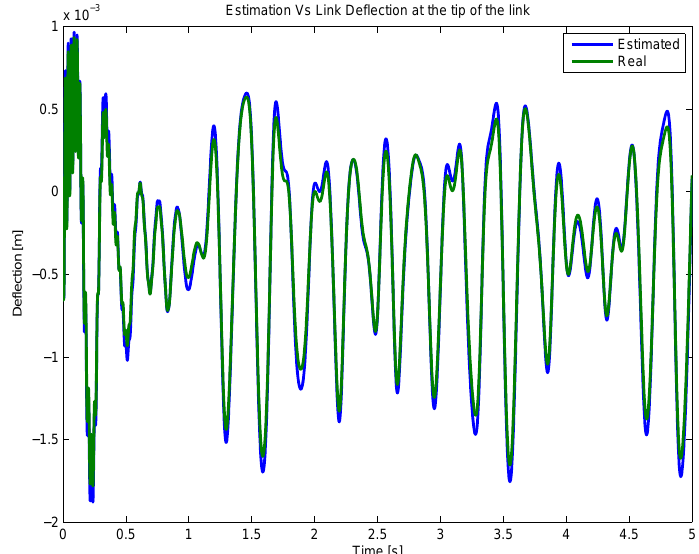
Figure 10. Virtual Sensor link deflection estimation compared with the real deflection at the tip of the link obtained with ADAMS Multibody